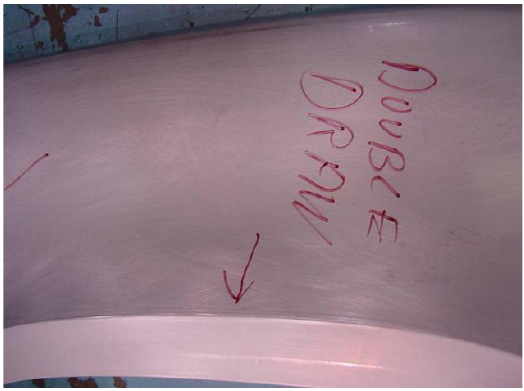
Figure 1. Skid line at the wheel eyebrow of automobile fender.